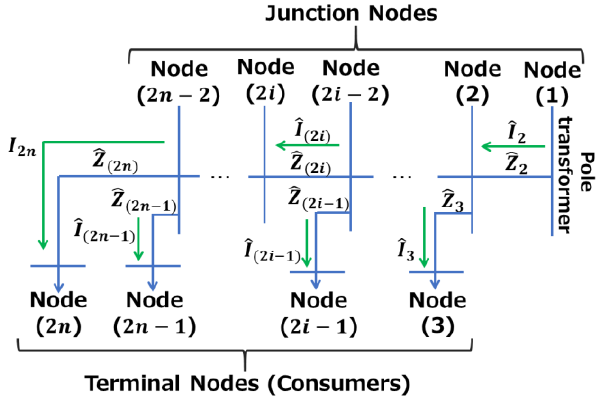
Figure 1. Simulation model: generalized linear Low-Voltage distribution network.